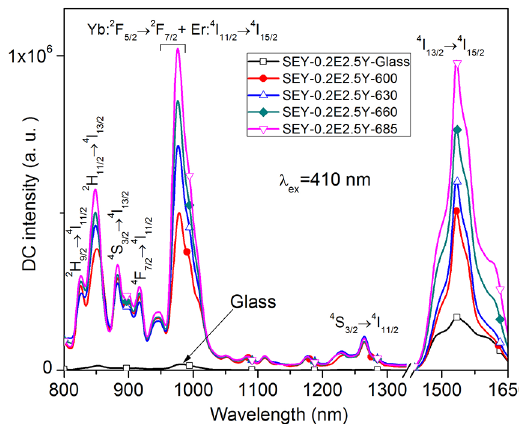
Figure 5. DC emission spectra of SEY-0.2E2.5Y-glass, SEY- 0.2E2.5Y-600, SEY-0.2E2.5Y-630, SEY-0.2E2.5Y-660 and SEY- 0.2E2.5Y-685 transparent glass-ceramics samples.